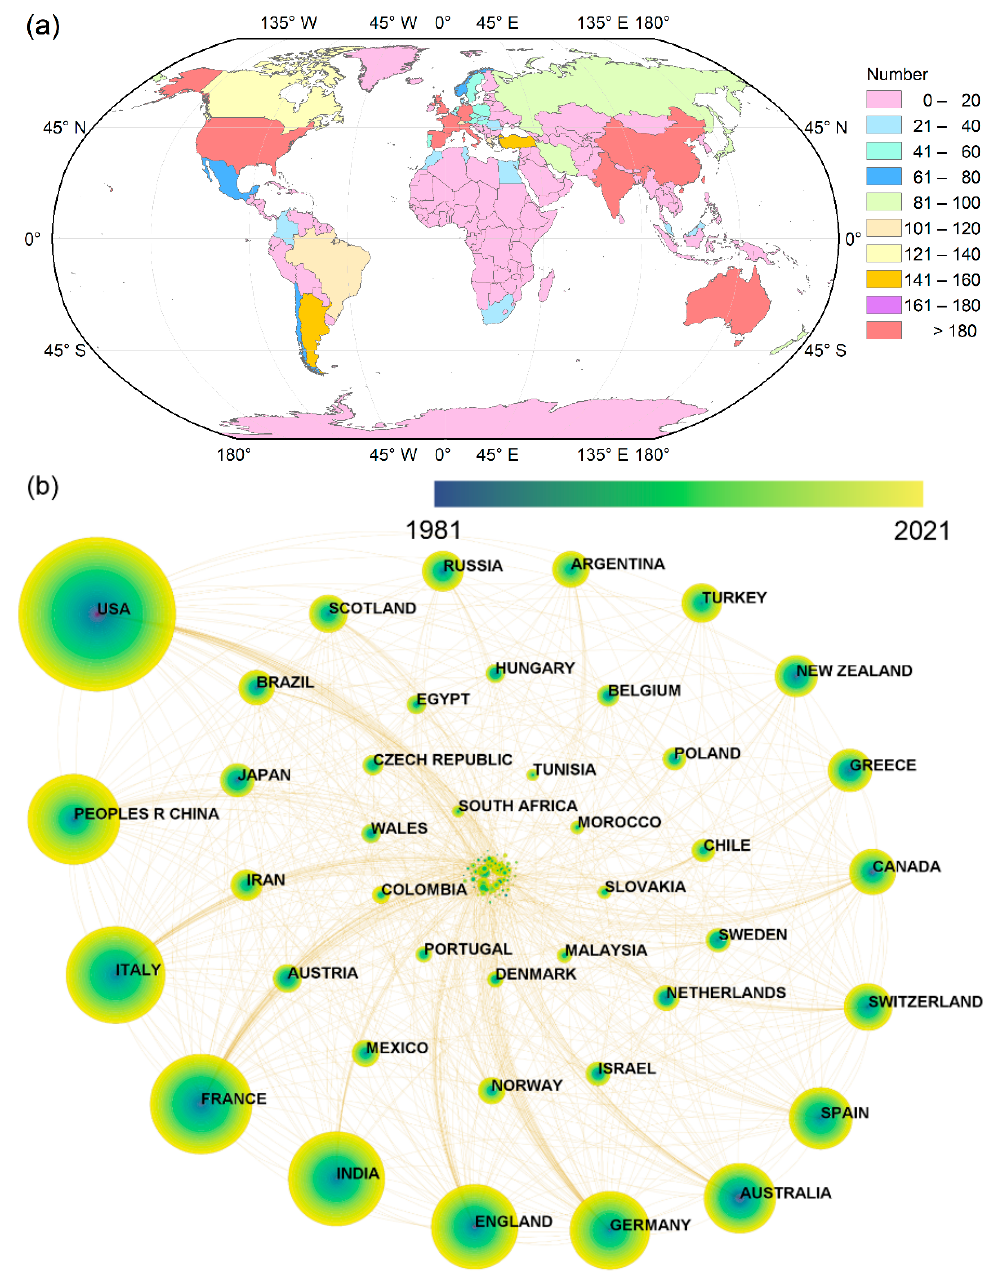
Figure 3. ( a ) The number of articles per country in tectonic geomorphology research, ( b ) the na- tional cooperation between different countries in tectonic geomorphology research from 1981 to